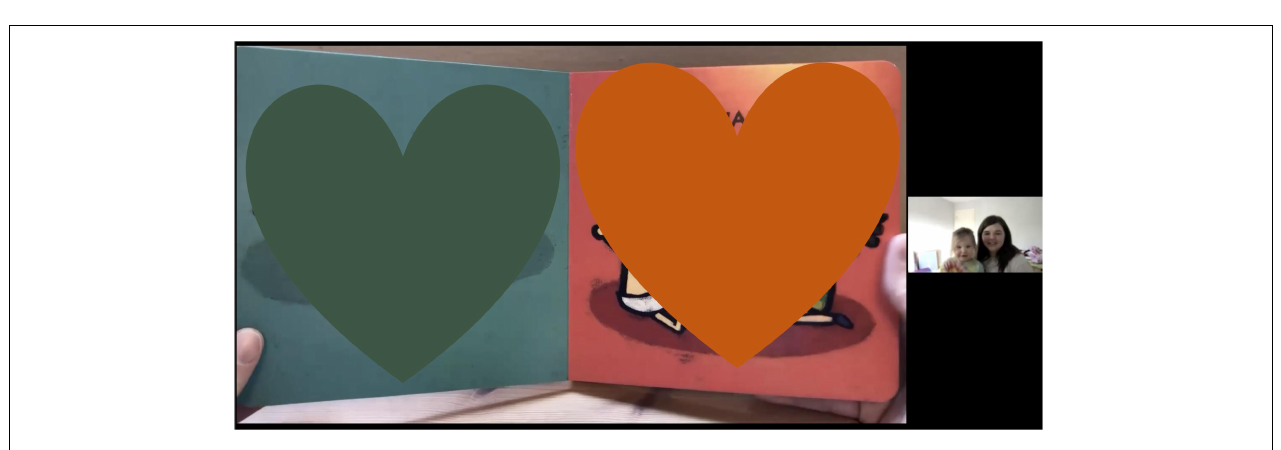
FIGURE 3 | Recommended positions for virtual visit.